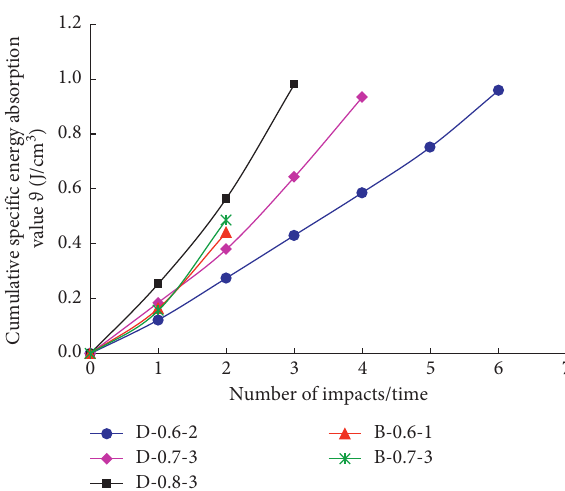
Figure 10: Relationship between the value of the cumulative specific energy and time of the impact